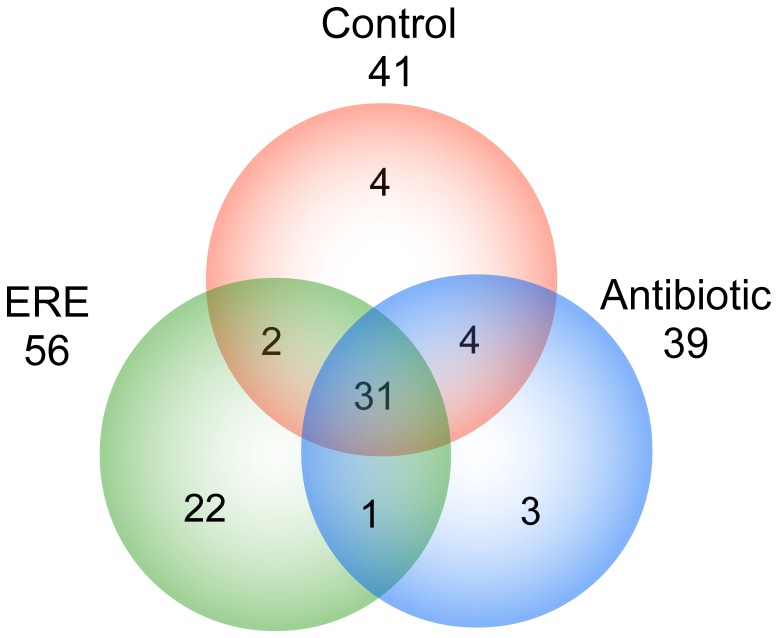
Venn diagram showing the relative abundance at the genus level based on the classification of the partial 16S rDNA bacterial sequences from cecal samples of antibiotic, healthy control and ERE groups using the RDP classifier software for taxonomy assignment: control group (healthy, no antibiotics) (Control), rabbits treated with antibiotics (Antibiotic) and ERE animals (ERE).